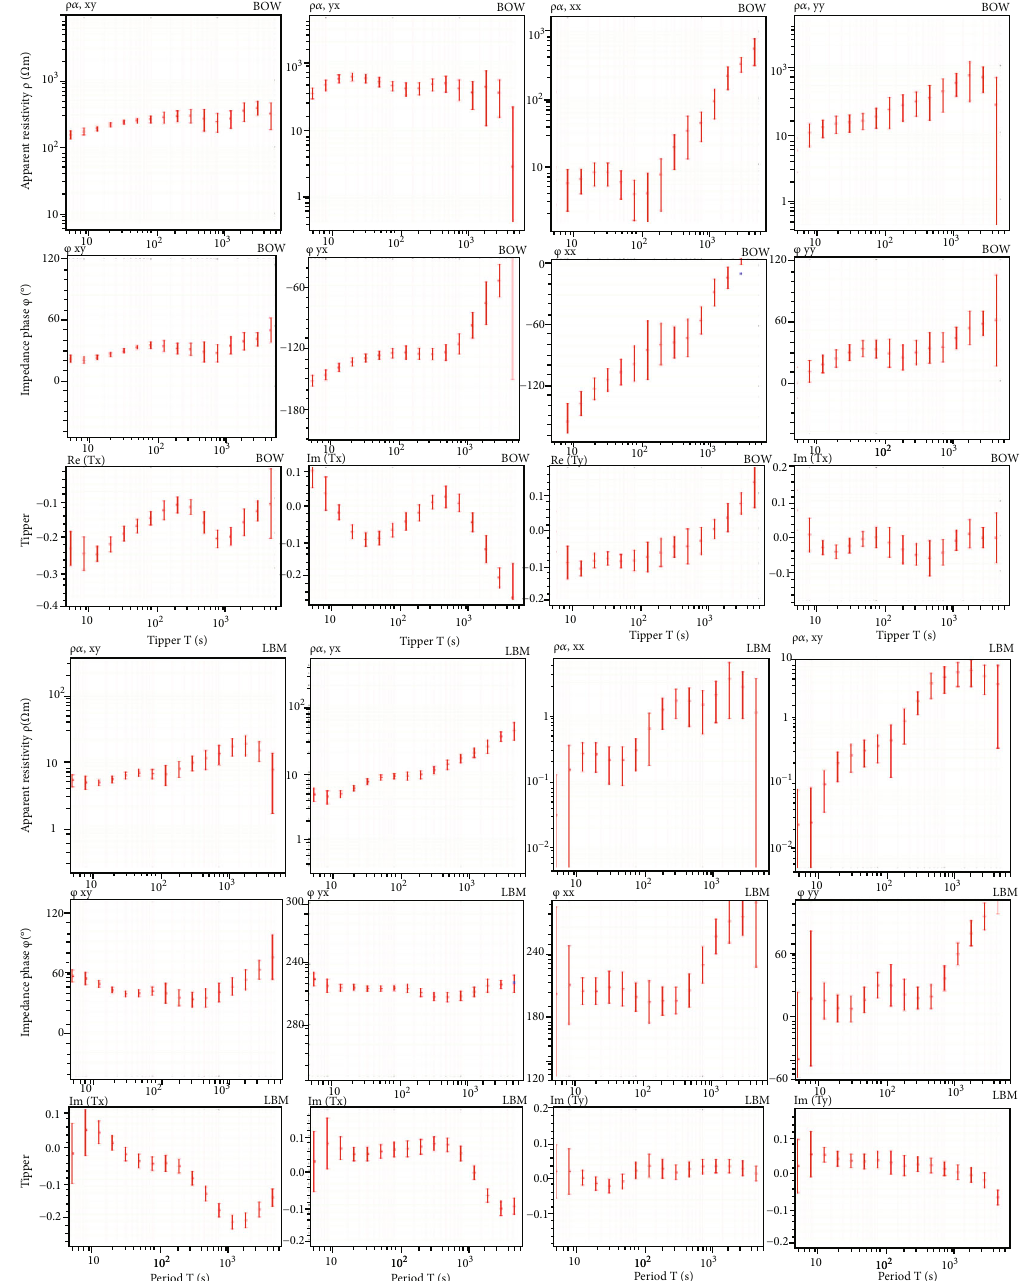
Figure 2: Examples of transfer functions (red) model response (blue) fi t the data after 3D